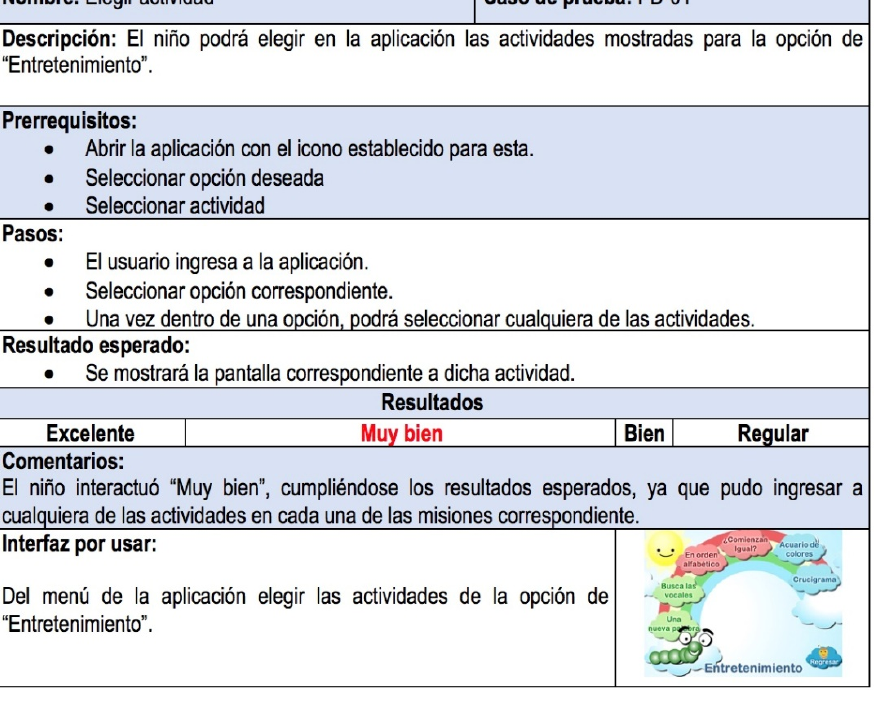
Figure 8. Example of a usability test design.